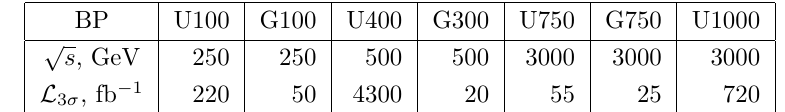
Figure 9 . Distributions of CW neutrino production signal (blue) and background (orange) events in M rec at the U100 (left panel) and G100 (right panel) benchmark points.